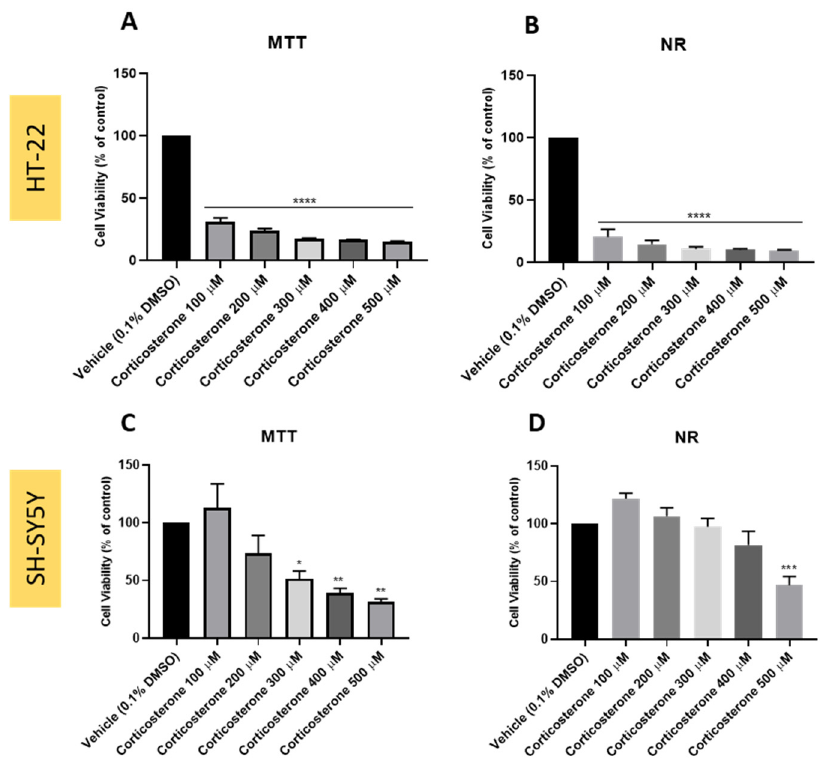
Figure 7. Effect of 48-h-incubation of 100–500 µ M of corticosterone on the viability of HT-22 and SH-SY5Y cells, determined by ( A , C ) MTT and ( B , D ) NR assays. The results represent the mean ± SEM of 3–6 independent experiments, expressed as the percentage of the vehicle (100%). Statistically significant * p < 0.05, ** p < 0.01, *** p < 0.001, and **** p < 0.0001 vs. vehicle.